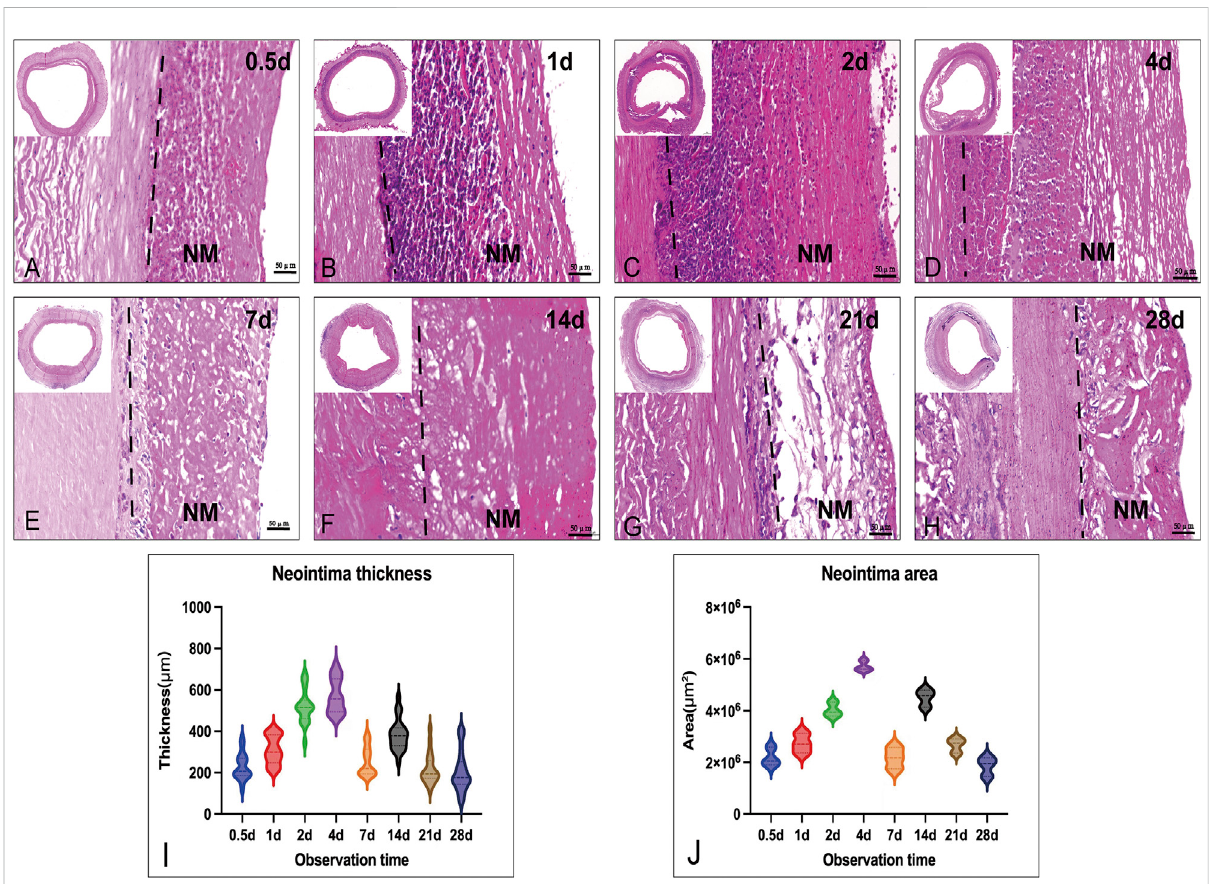
FIGURE 2 Histological images (H&E) of the neointima change in thickness and area in the vascular lumen at different times. (A – H) : the cross- section morphology of Implanted graft at different times (up-right: time points, scale bar = 50 μ m); (I) : Measurements of average neointima thickness in different grafts; (J) : Measurements of the area in different grafts: Both thickness and area had the larger value at day 4 (thickness: 700 μ m; area: 6 × 10 μ m ^ 2). NM: